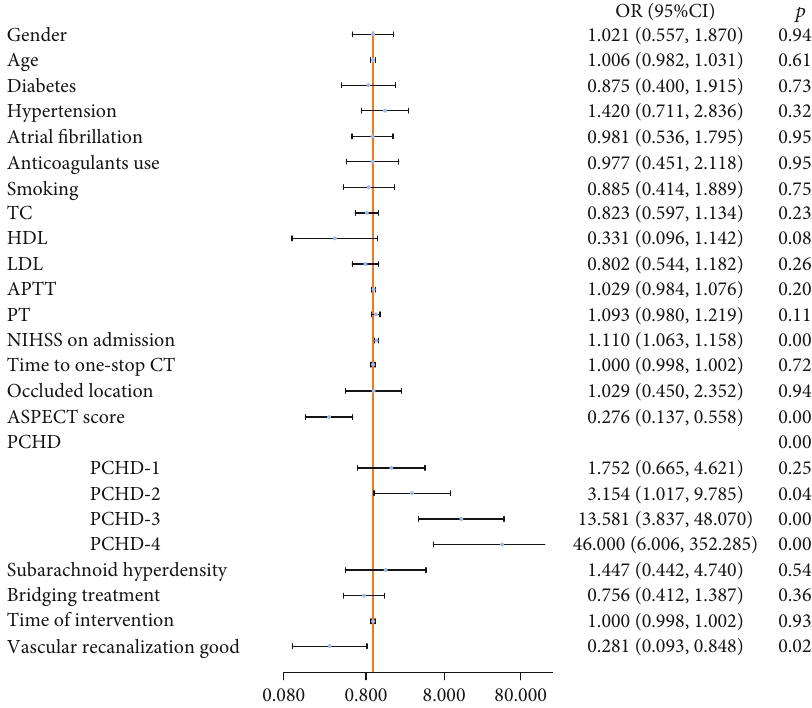
Figure 6: Univariate predictors of the mRS score at 3